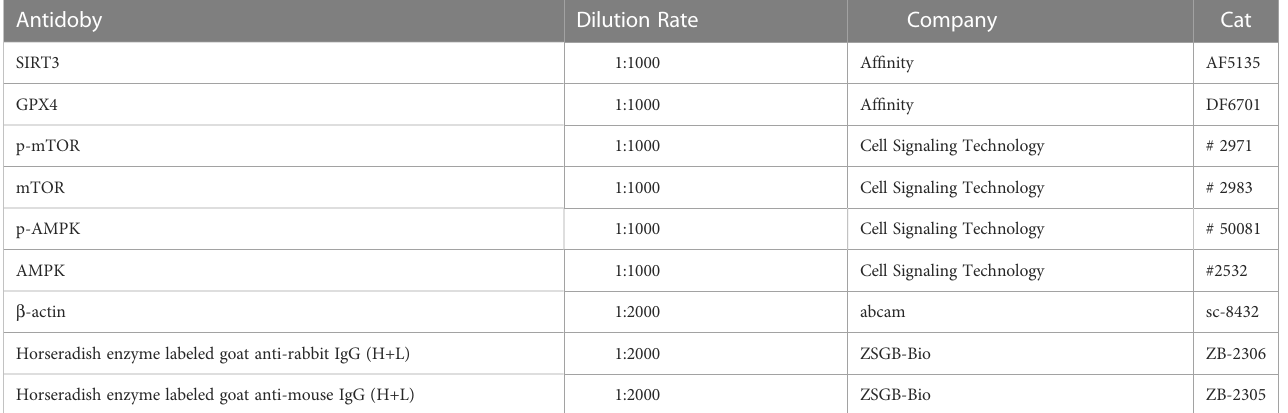
TABLE 1 Antibodies of